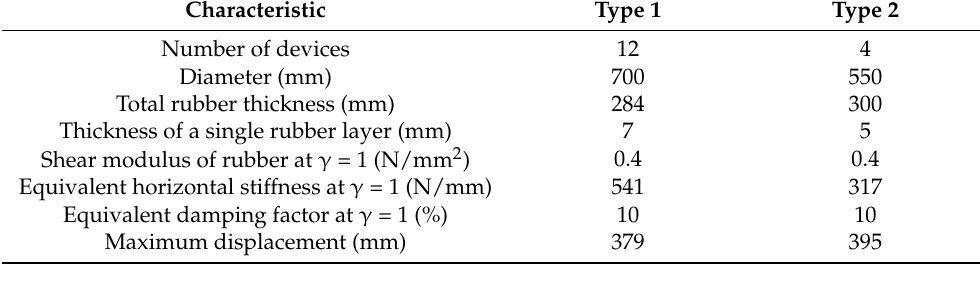
Table 1. Nominal characteristics of the two types of HDRBs.